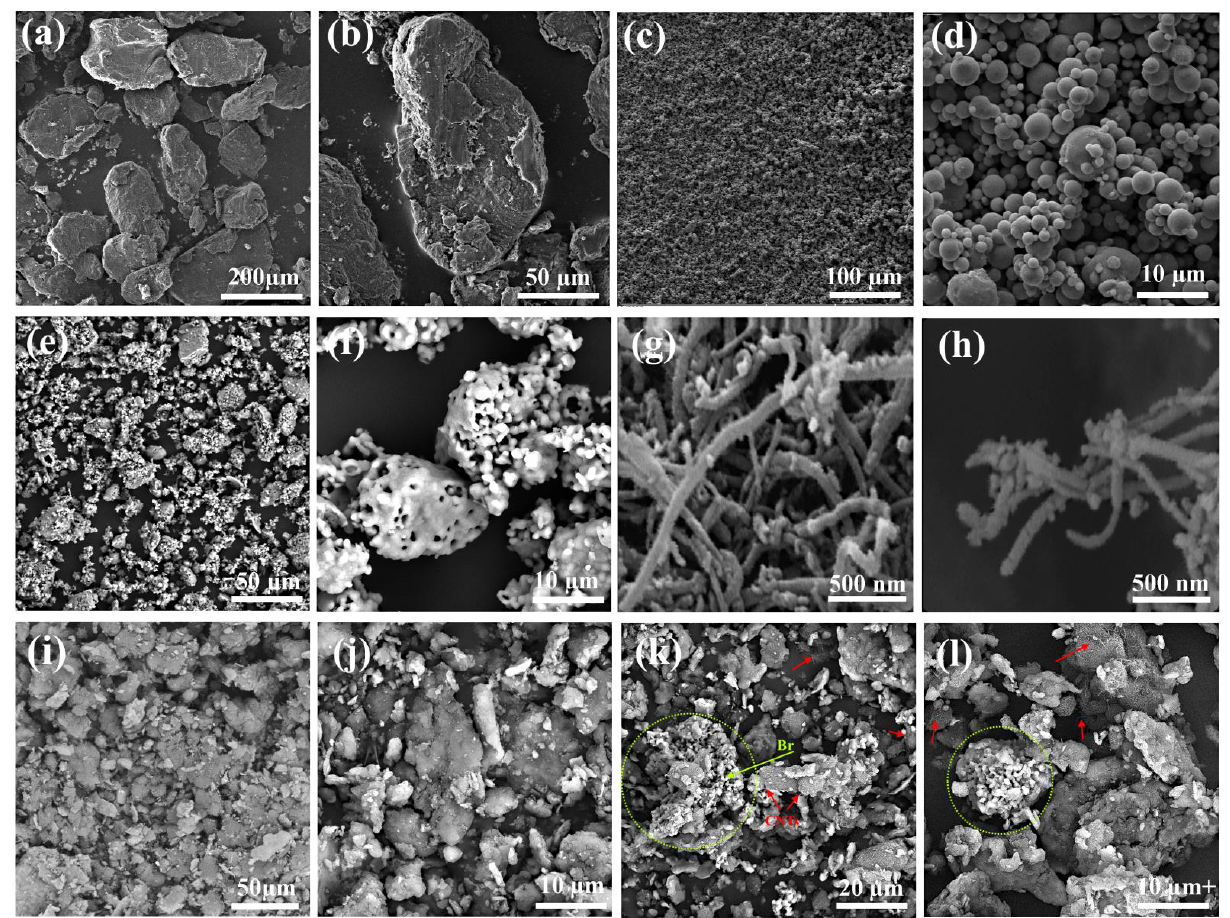
Figure 2. SEM images, at different magnification of ( a ) Mg ×300, ( b ) Mg ×1000 ( c ) Zn ×500, ( d ) Zn ×5000, ( e ) bredigite ×1000, ( f ) bredigite ×5000, ( g ) CNTs ×60,000, ( h ) CNTs ×60,000, ( i ) MZ ×1000, ( j ) MZ ×5000, ( k ) MZ/Br-CNTs ×2000 and ( l ) MZ/Br-CNTs ×3500 powder composites.